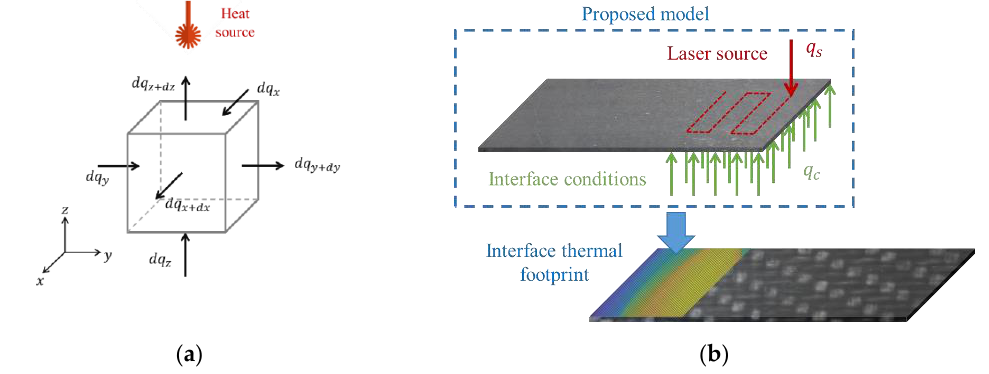
Figure 3. ( a ) Energy balance in each element. ( b ) Description of joining.